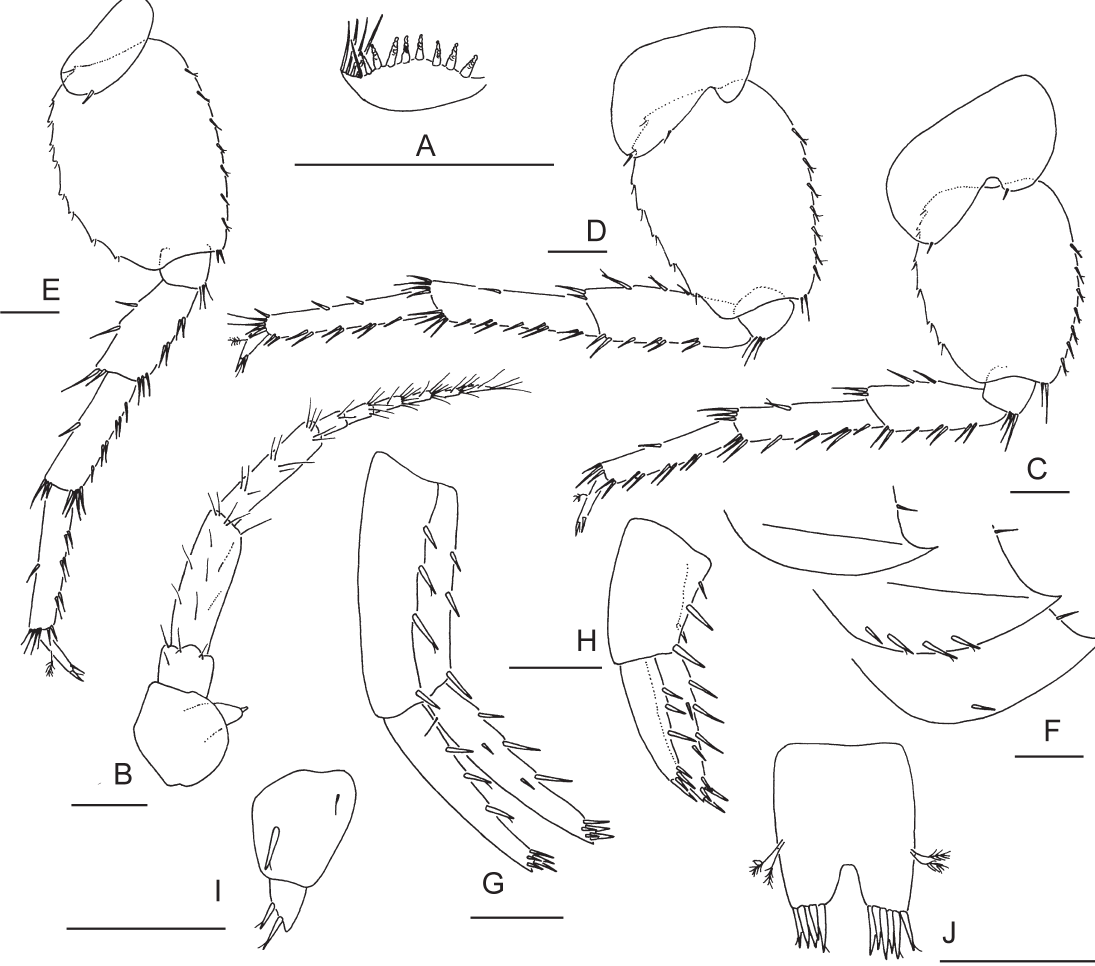
Fig. 8A-J. Synurella ambulans (F. Müller, 1846), ♀, 4.0 mm, FENU X34906/Cr-1406, KF. A . Lateralia. B . Antenna 2. C . Pereopod 5. D . Pereopod 6. E . Pereopod 7. F . Epimera 1-3. G . Uropod 1. H . Uropod 2. I . Uropod 3. J . Telson. Scale bars 0.2